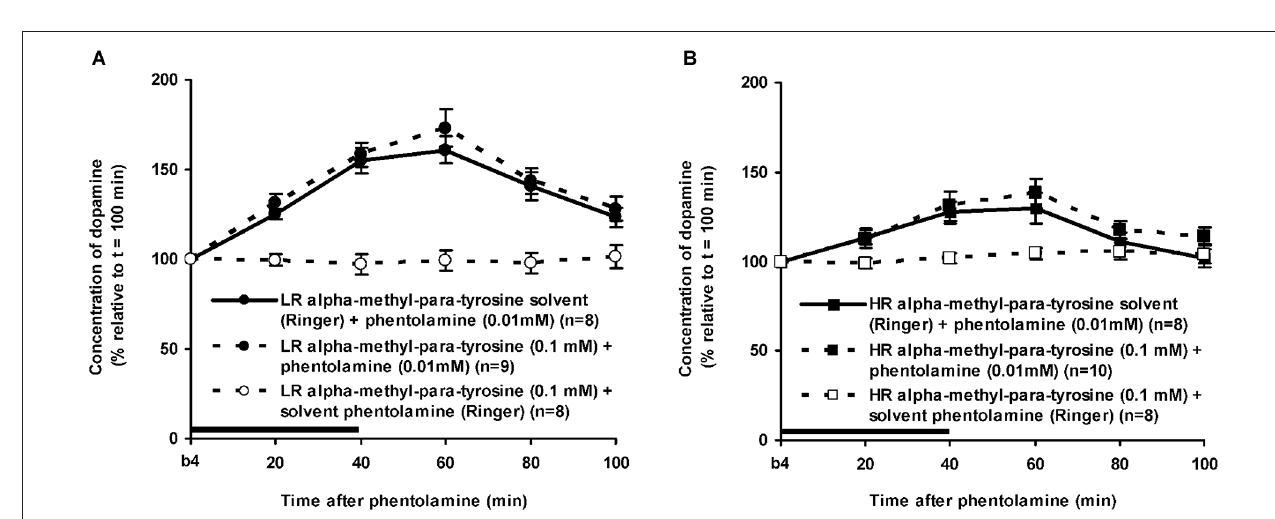
FIGURE 6 | Effects of the intra-accumbens infusion of the alpha-adrenoceptor-antagonist PA (0.01 mM, 2 µ l/min, 40 min) on the extracellular concentration of DA in the nucleus accumbens of LR (A) and HR (B) under non-novelty-challenged conditions . All rats were treated with the solvent of AMPT. Values are accumbal DA